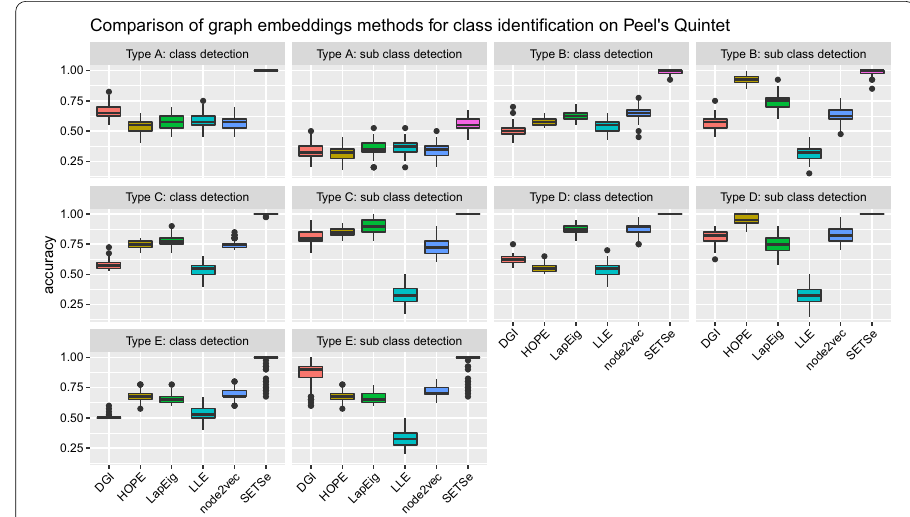
Fig. 6 Using the knowledge of the groups, SETSe greatly outperforms the other node embedding techniques, at separating the classes and sub-classes for each type of Peel’s quintet. The upper and lower bounds on the boxes describe the 26th and 75th percentiles. The whiskers are 1.5 times the inter-quartile